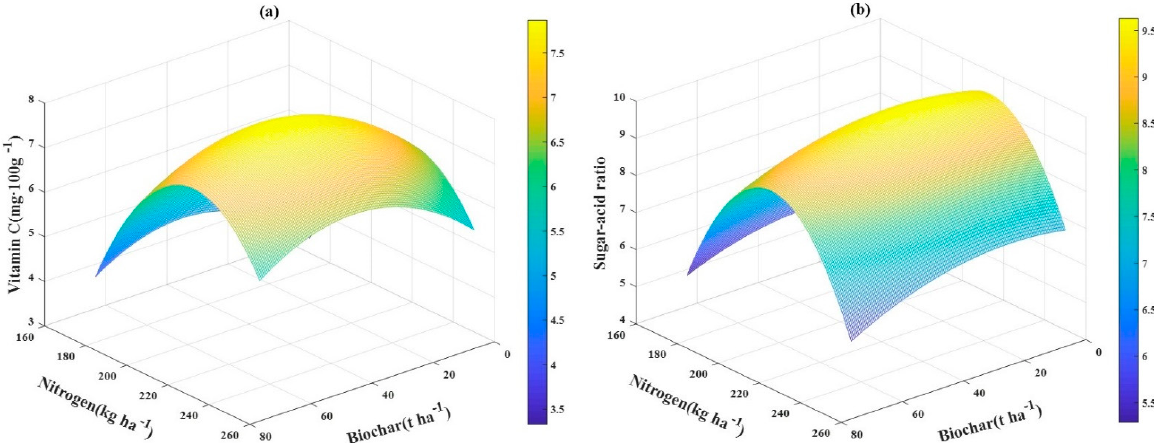
Figure 2. The relationship between VC ( a ) and sugar-acid ratio ( b ) and biochar C-fertilizer N application rates as a 3D color maps.